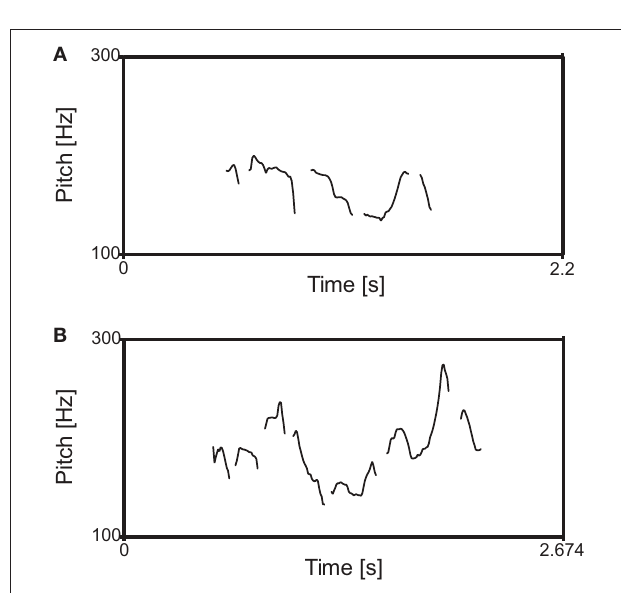
FIGURE 3 | F -contour of one authentic (A) and one play-acted (B) anger 0 stimulus (text fragment: “[Polizei]präsenz is und so, was hier los ist,” translated: “[police] presence is and such, what is going on here”) that demonstrates the higher F -variability of the play-acted stimuli. The 0 pitch-contour was generated